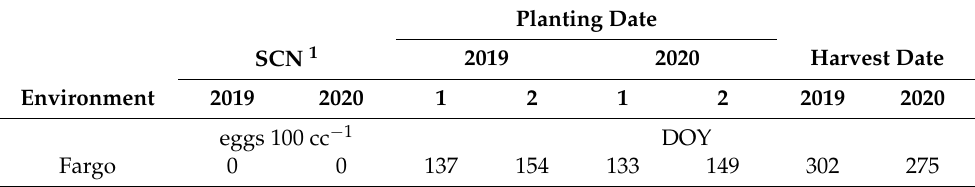
Table 1. Important dates and environment information for 2019 and 2020 soybean environments. Planting Date